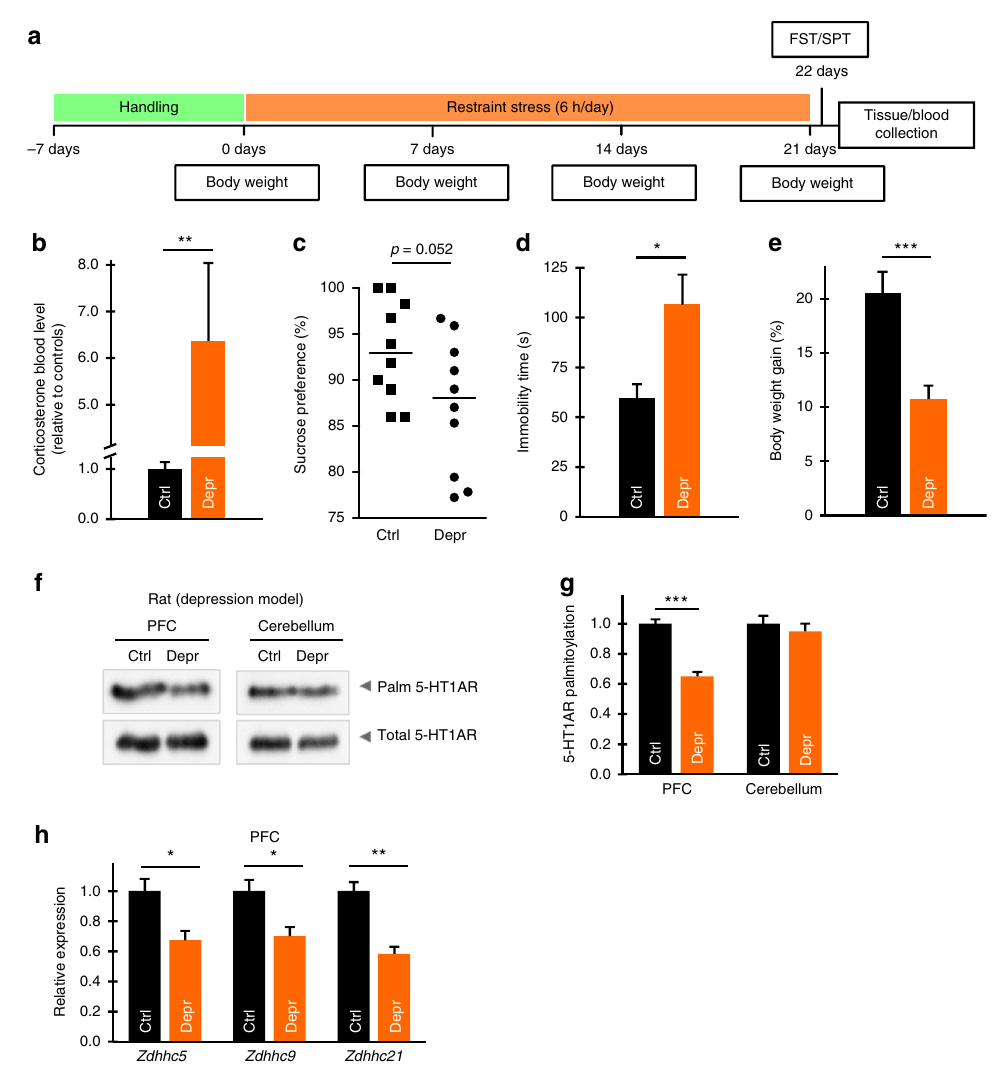
Fig. 4 Palmitoylation of 5-HT1AR and expression of ZDHHC21 are decreased in the forebrains of rats with depression-like phenotype. a Schematic diagram of experimental design for restraint stress depression model in Wistar rats. b Normalized corticosterone blood level of the control (ctrl) and rats with depression-like behavior (depr). c Results of the sucrose preference test in control and chronically stressed rats. d The duration of immobility in the forced swim test of the control and rats with depression-like behavior. e Body weight gain during experiment of the control and rats with depression-like behavior. Data points in b – e represent mean ± SEM. ( n = 10 for each group; * P < 0.05; ** P < 0.01; *** P < 0.001). f Prefrontal cortex (PFC) and cerebellum of the control Wistar rats (ctrl) and rats with depression-like behavior (depr) were subjected to acyl-biotinyl exchange to visualize 5-HT1AR palmitoylation. g Bar graphs representing normalized level of 5-HT1AR palmitoylation in control ( n = 5) and rats with depression-like behavior ( n = 5) animals. All blots are representative of at least three independent experiments. Data points represent the means ± SEM. * P < 0.05; *** P < 0.001, two-tailed t test (see also Supplementary Fig. 6A – E). h Relative expression levels of ZDHHC5, -9, and -21 in the PFC of control rats and rats with depression-like phenotype (two- tailed t test, see also Supplementary Fig. 6F, G). Source data are available as a Source Data fi ZDHHC21 knockdown in PFC triggers depressive symptoms . Zdhhc21 expression in the non-injected brain regions, like cere- To test for a causal relationship among the level of ZDHHC21, bellum (Supplementary Fig. 7F). Also, the expression of 5- the degree of 5-HT1AR palmitoylation, and initiation of HT1AR in the PFC, hippocampus, and cerebellum was not depressive symptoms, we selectively knocked down the expres- changed after AAV injection (Fig. 5c, e; Supplementary Fig. 7G). sion of this palmitoyl acyltransferase in the PFC of mice. To do General palmitoylation patterns as well as palmitoylation of so, we generated an adenovirus-associated viral (AAV) construct NCAM140, used as a control, were not affected in the mouse brain after PFC injection of AAV encoding for the shRNA against ZDHHC21 along with the red fl uorescent protein under control infected neurons (Fig. 5a; Supplementary Fig. 7A – C, E). Bilateral reduced in the PFC (Fig 5c, e, Supplementary Fig. 7G), further